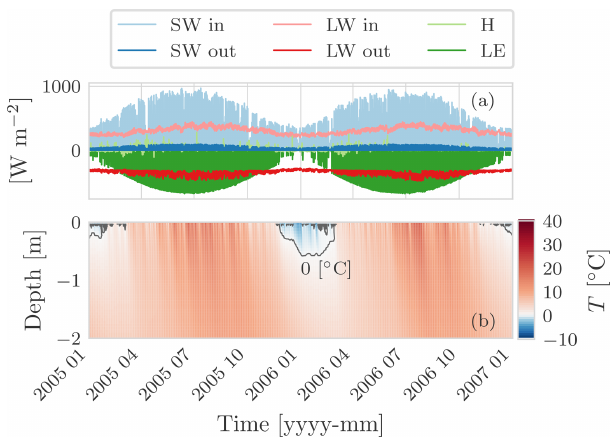
Figure D2. Behavioural test case of pure heat conduction in soil considering the surface energy budget and the phase change of wa- ter. (a) The surface energy fluxes driving the simulation. The ex- ternal fluxes, incoming shortwave and longwave radiation, and the latent heat flux are computed with existing GEOframe components.